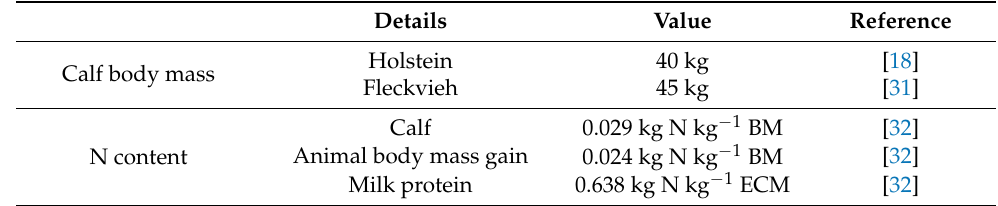
Table 1. Biometric data used for N balance.